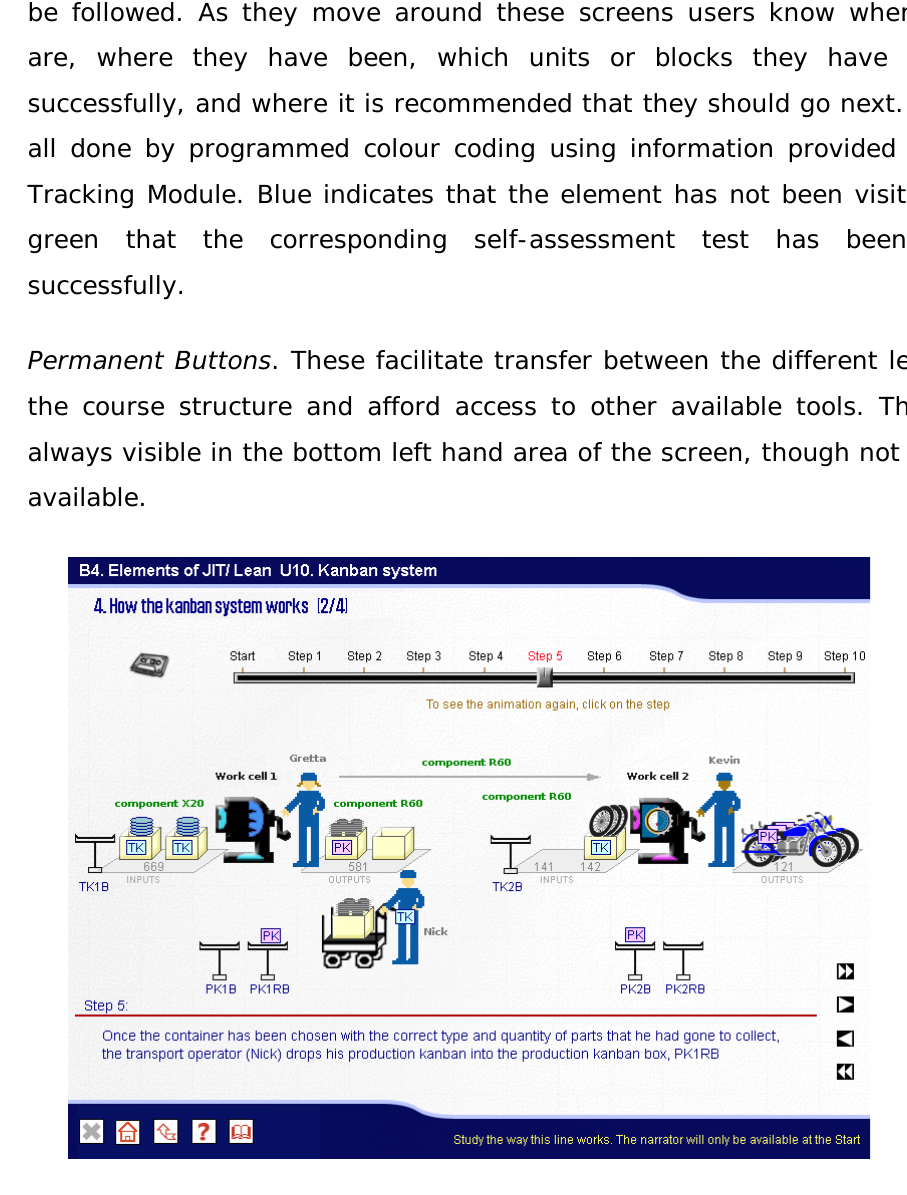
Figure 5. “Example of content